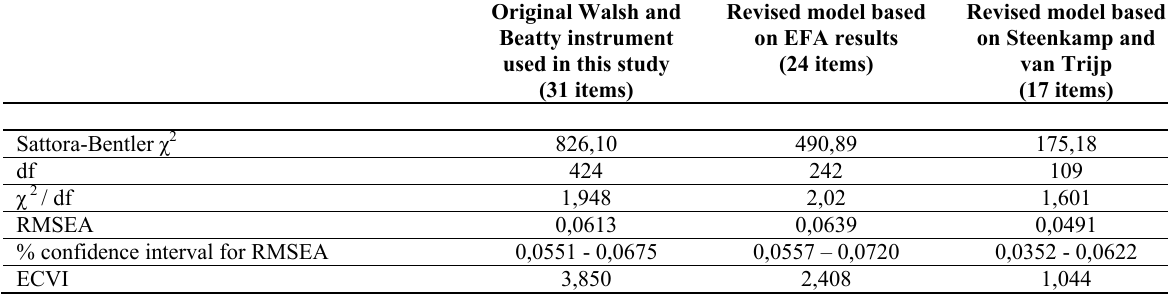
Table 2: Fit indices: sample 1